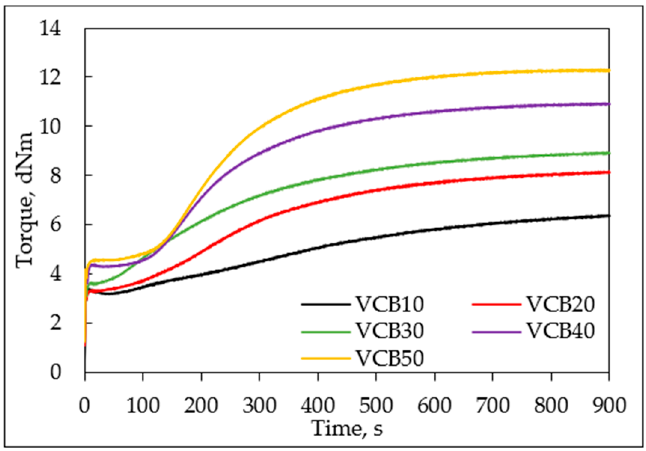
Figure 6. Vulcanization curves, obtained after 15 min at 150 °C .